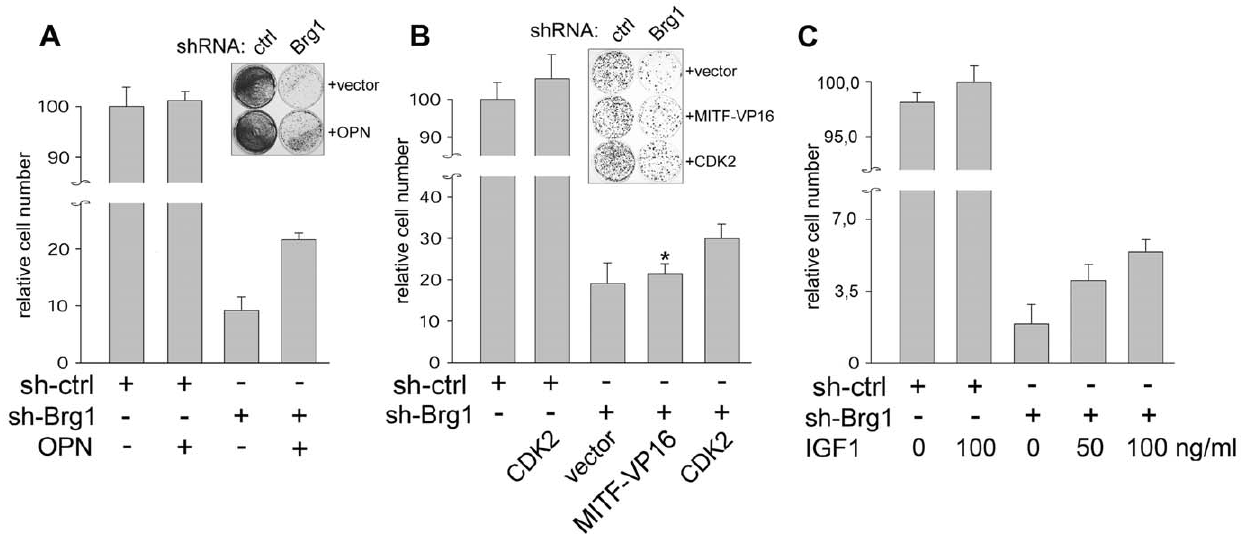
Figure 6. Separate restitution of OPN, CDK2 or IGF1 partly rescued cell proliferation. A. Addition of recombinant OPN (50 m g/ml) can partly increase colony formation of BRG1-silenced 501mel cells. OPN has been added 1 day after shRNA encoding plasmid and fresh OPN was replaced two days later. Cells were analyzed 5 days after transfection. The values are means of duplicates + -SE. One of four independent experiments is shown. B. Overexpression of CDK2 (by use of a CDK2-FLAG expression plasmid), but not the MITF-VP16 chimera [41] slightly rescues colony formation of BRG1-silenced cells 501mel cells. *, not statistically significant (P , 0.05), compared to control. CDK2-FLAG was efficiently expressed, estimated by Western blot (not shown). C. Exogenously added recombinant IGF1 protein partly restores colony formation of BRG1-depleted 501mel cells in a dose-dependent manner. No effects of added recombinant factors or CDK plasmid were seen in control shRNA cells. The values are means of duplicates + -SE. Western blot detecting OPN and RT-PCR detecting IGF1 mRNA showed no increase of their levels in cell extract (not shown), evidently because these factors are added as recombinant proteins and exert their effects via cell receptors. In B and C, one of three independent experiments is depicted. Relative cell number was estimated by staining with crystal violet as described in Materials and